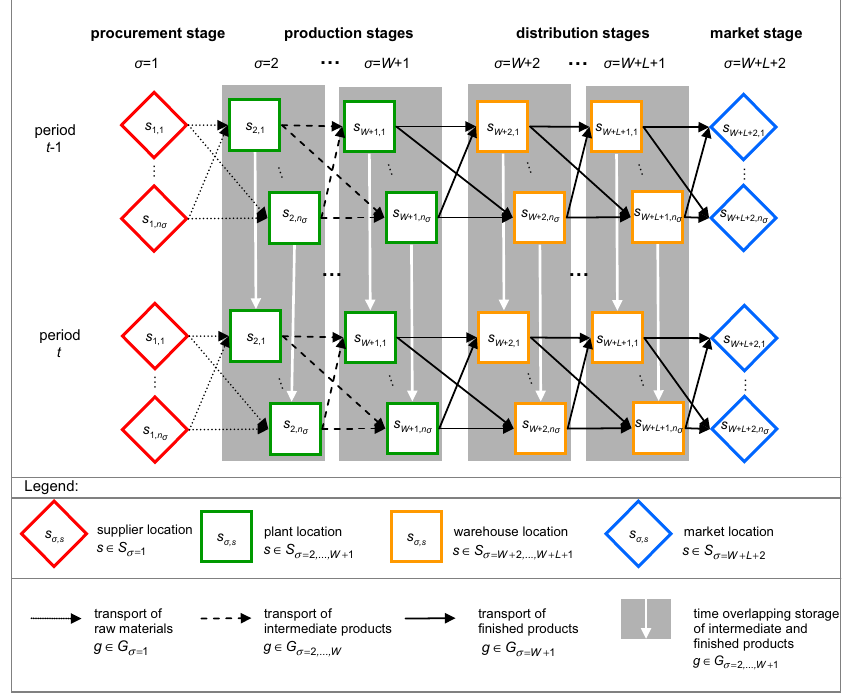
Fig. 1 Supply chain